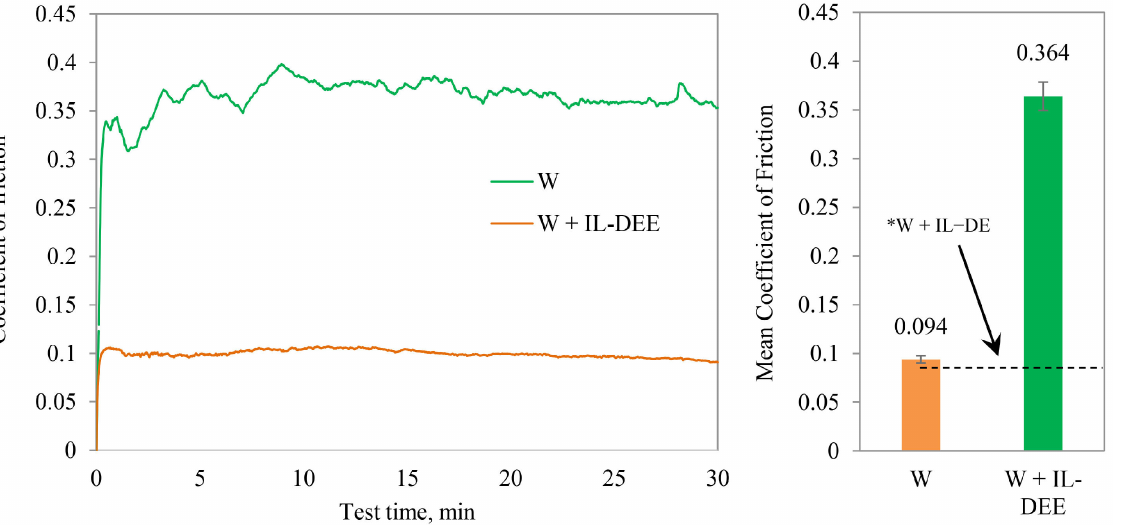
Figure 11. Variations of the coefficient of friction and its mean value observed during the W + IL-DEE tribo-test. * value of the coefficient of friction observed in our previous study